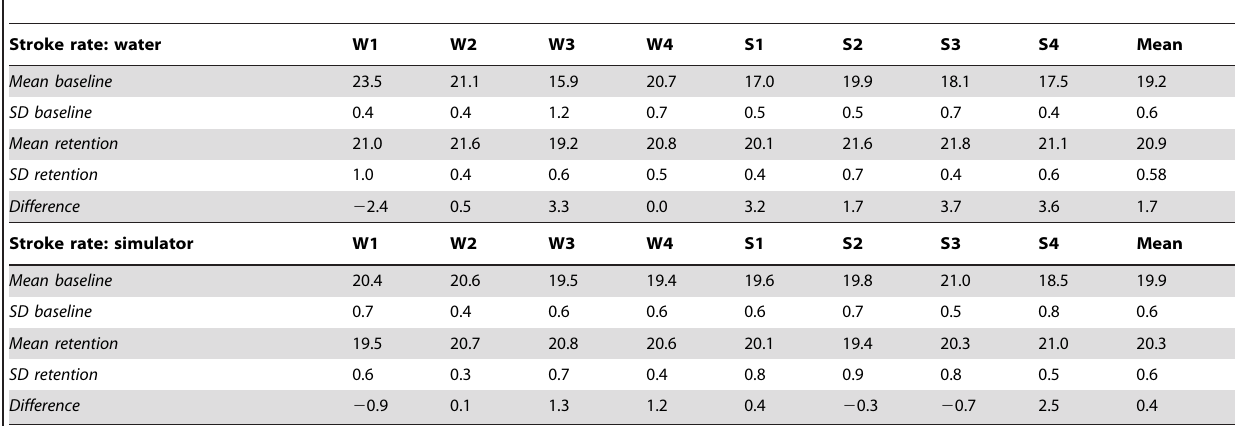
Table 2. Stroke rates